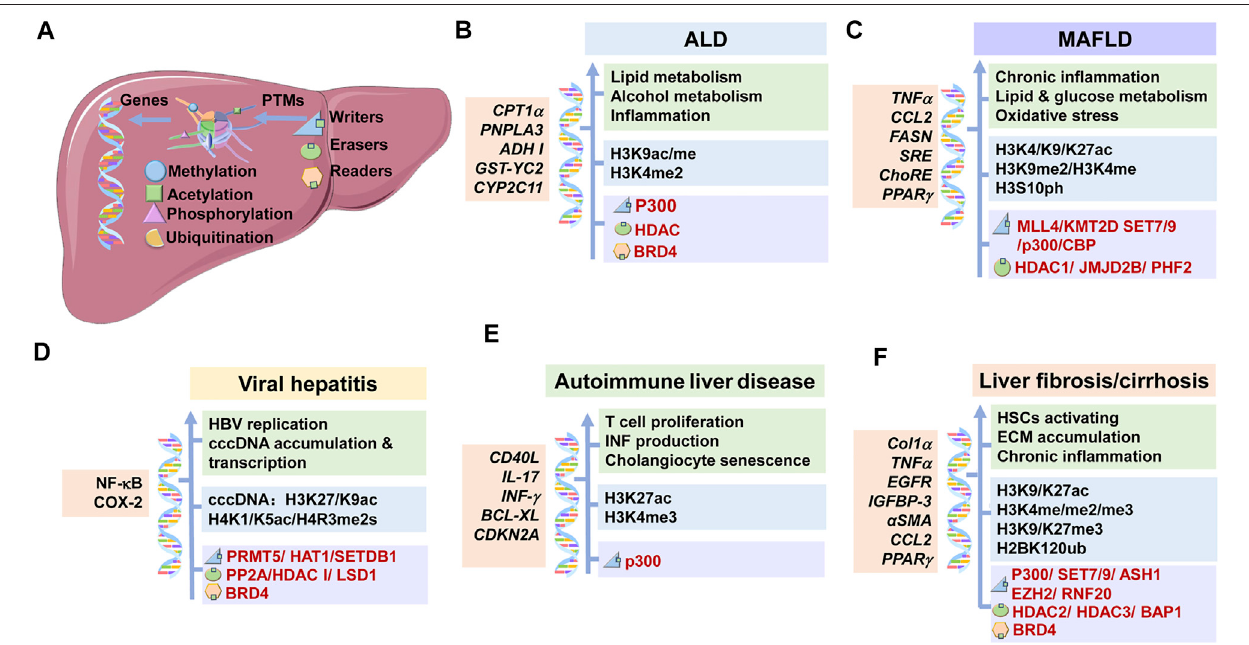
FIGURE 3 | Underlying mechanisms of histone modi fi cations in CLDs. The main histone modi fi cations, the targeted genes, the corresponding effects and the therapeutic targets in CLDs were shown. (A) Modi fi cations of histones are mediated via writers and erasers, and are recognized by readers. These modi fi cations work through changing the expression of corresponding genes. (B) In ALD, p300, HDAC, and BRD4 mediate the histone modi fi cations at speci fi c genes, which regulate lipid and alcohol metabolisms and in fl ammation reaction. (C) In MAFLD, p300/CBP, HDAC1, SET7/9 et al. mediate the histone modi fi cations at speci fi c genes, which promotechronicin fl ammation,lipidandglucosemetabolismandoxidativestress. (D) Inviralhepatitis,PRMT5,HDAC1,BRD4 etal. mediatethehistonemodi fi cationsat speci fi c genes, which regulate HBV replication, cccDNA accumulation and transcription. (E) In autoimmune liver disease, p300 and other proteins mediate the histone modi fi cations at speci fi c genes, which promote T cell proliferation, INF production and cholangiocyte senescence. (F) In liver fi brosis/cirrhosis, p300, SET7/9, HDAC 3 et al. mediate the histone modi fi cations at speci fi c genes, which promote HSC activation, ECM accumulation and chronic in fl ammation. ALD: alcoholic liver disease; MAFLD: metabolic-associated fatty liver disease; HSC: hepatic stellate cell; IFN: interferon; ECM: extracellular matrix.